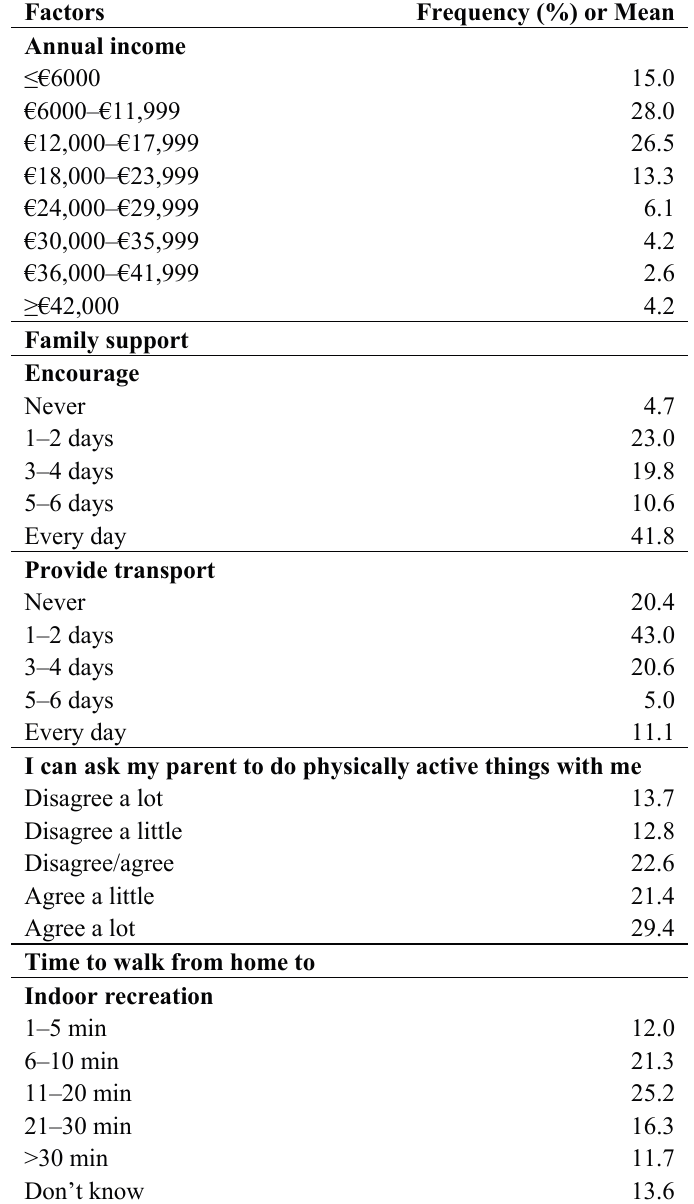
Table 2. Summary information regarding individual items from biological, demographic, social, psychological, environmental and behavioral